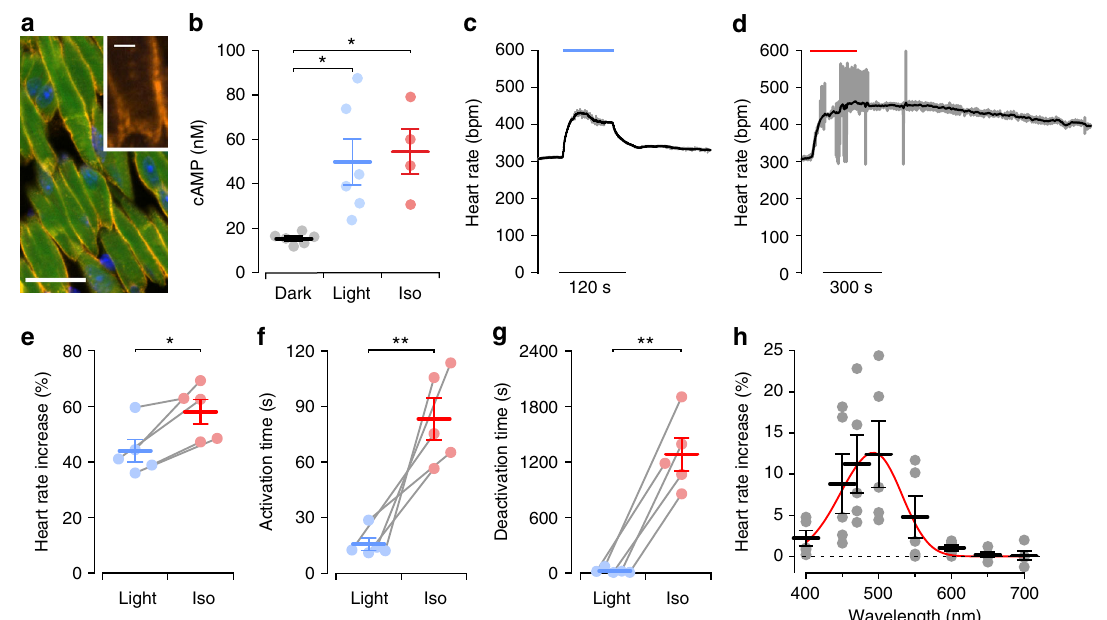
Fig. 5 JellyOp function in mouse atria of intact hearts. a Section through the right atrium shows GFP (green) and membrane-bound JellyOp-1D4 epitope signals (yellow, nuclear staining in blue, bar: 20 µ m, insert: 5 µ m). b Analysis of cAMP levels in atrial tissue from JellyOp mice in the dark and after illumination (2.86 μ W mm − 2 , 5 min) or stimulation with isoprenaline (Iso, 1 µ M, 5 min) ( n = 4 – 6, one-way ANOVA: p = 0.0074, Bonferroni post-test: * p < 0.05). c , d Representative heart rate traces of a JellyOp heart during maximal light stimulation of the dorsal right atrium ( c , blue bar, 2 mW mm − 2 , 90 s) or during perfusion with isoprenaline ( d , red bar; 1 µ M, 4 min) (gray: original trace, black: running average values). e – g Statistical analysis of the maximal relative heart rate increase ( e ), activation time ( f , stimulation start to 80% of maximum rate), and deactivation time ( g , stimulation end to 50% of maximum rate) after illumination (blue, 2 mWmm − 2 , 90 s) and perfusion with isoprenaline (red, 1 µ M, 4 min) ( n = 5, two-sided paired Student's t -test: p = 0.0248 ( e ), p = 0.0058 ( f ), p = 0.0017 ( g )). h Relative heart rate increase after illumination of the dorsal right atrium with light of